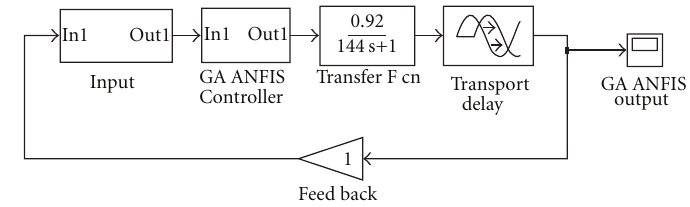
Figure 13: Simulink model of GA ANFIS controller.